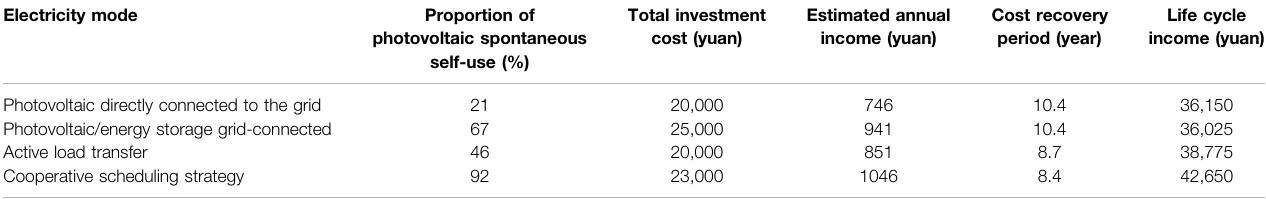
TABLE 3 | Electricity consumption model revenue data (Wang et al.,